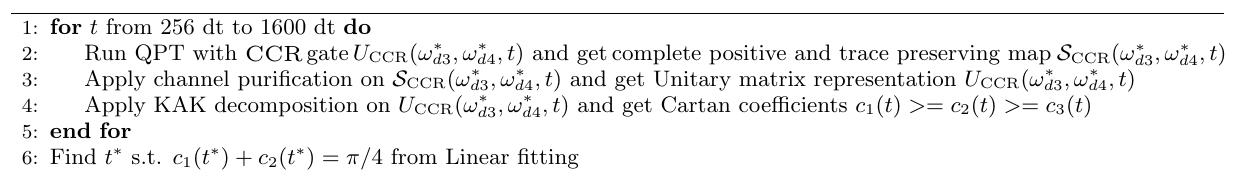
Algorithm 1. Calibration of CCR drive frequencies